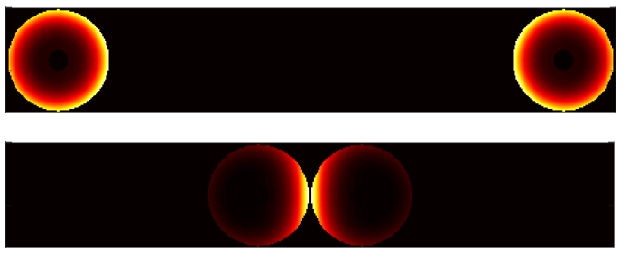
Figure 6: Normalized current distribution at 𝜁 = 5.0 .